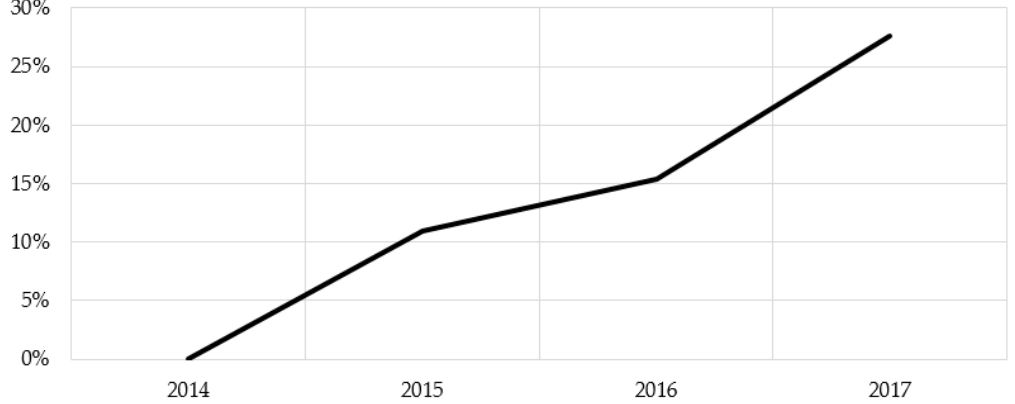
Figure 1. Health Star Rating (HSR) system uptake by proportion of HSR eligible products displaying the HSR logo or permitted energy icon in the FoodSwitch Monitoring Database.